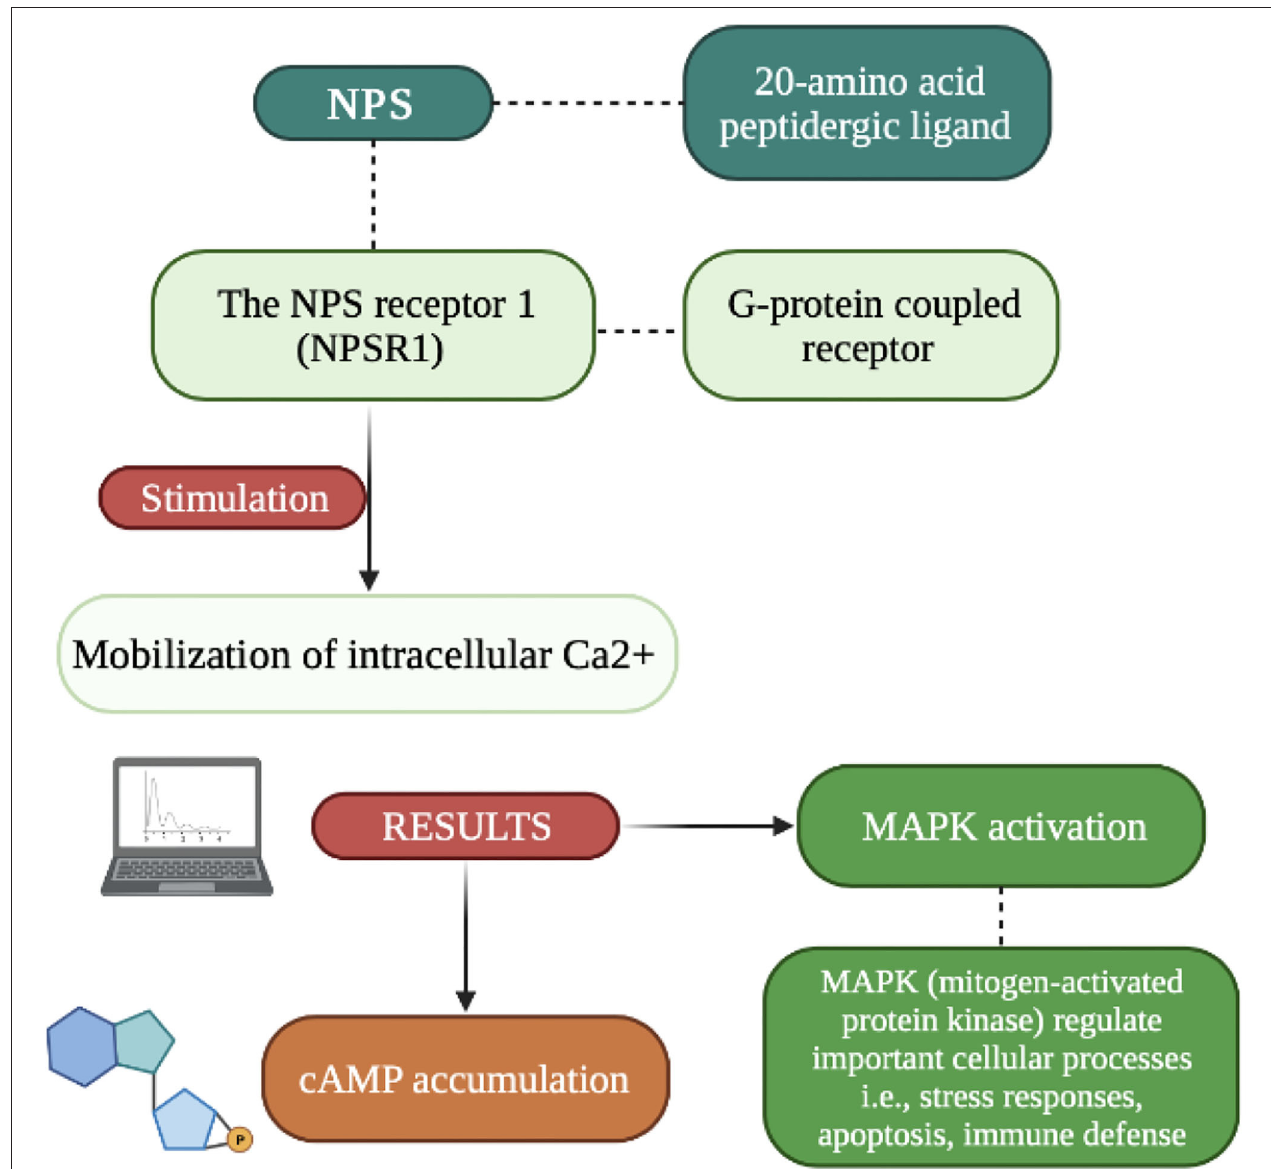
FIGURE 1 | Picture showing the effects of NPSR1 receptor stimulation (82,